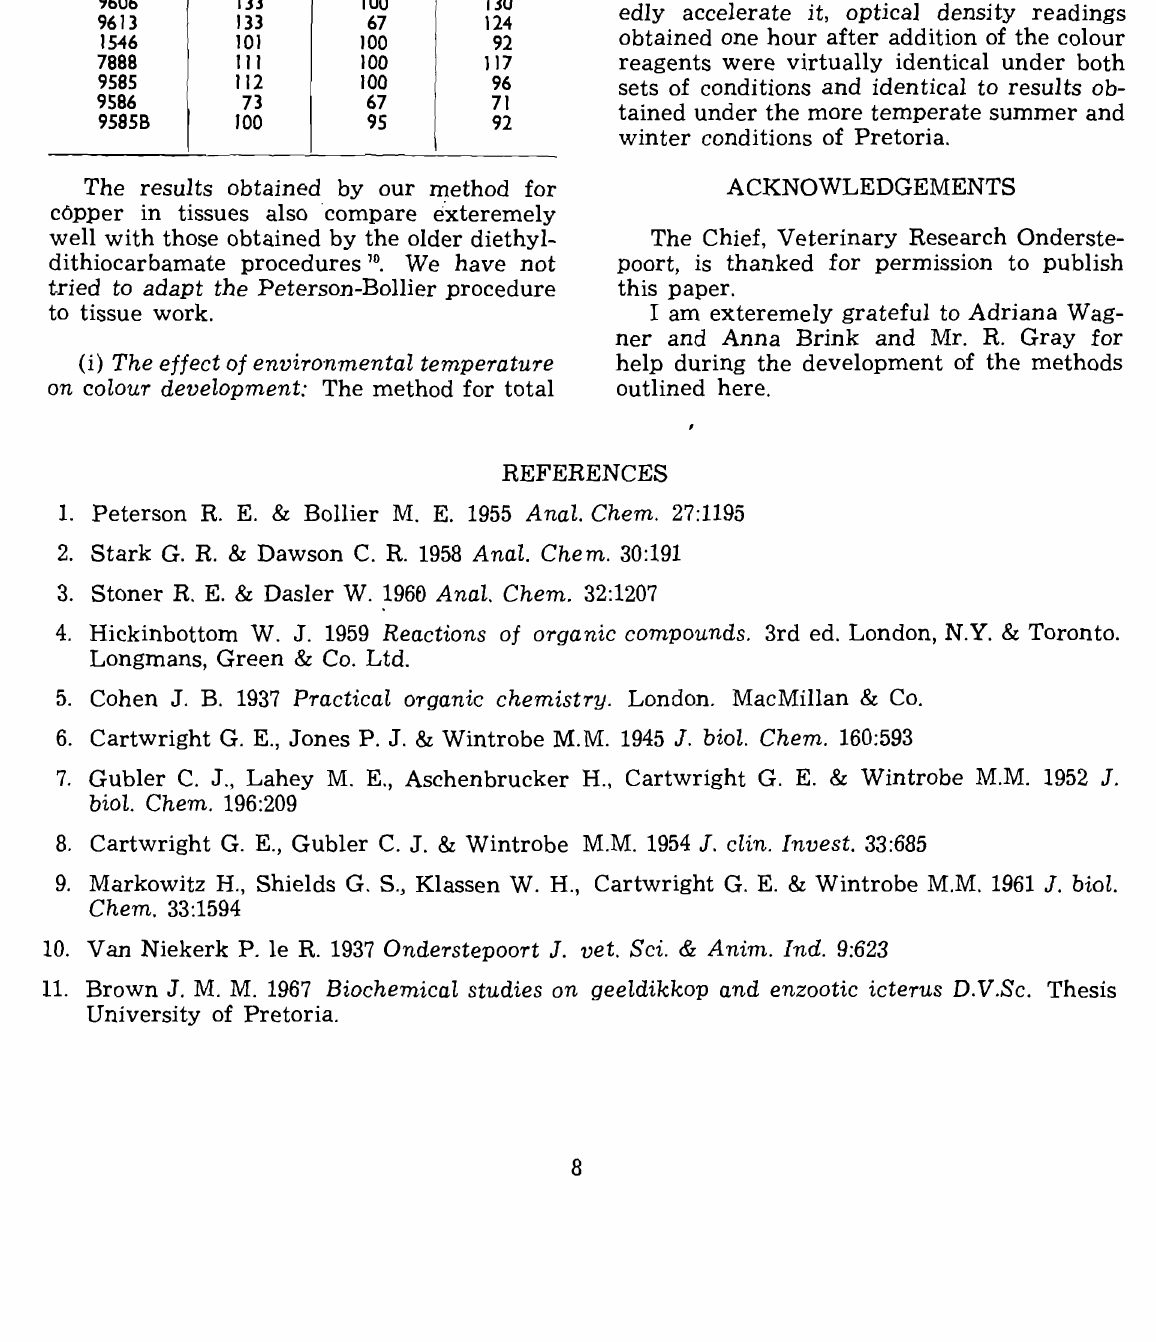
TABLE 3: COMPARISON OF RESULTS OBTAINED BY THE PROPOSED METHOD WITH THOSE OBTAINED BY EARLIER PROCEDURES Cartwright Peterson & Our method Sample No. et al Bollier mCI%